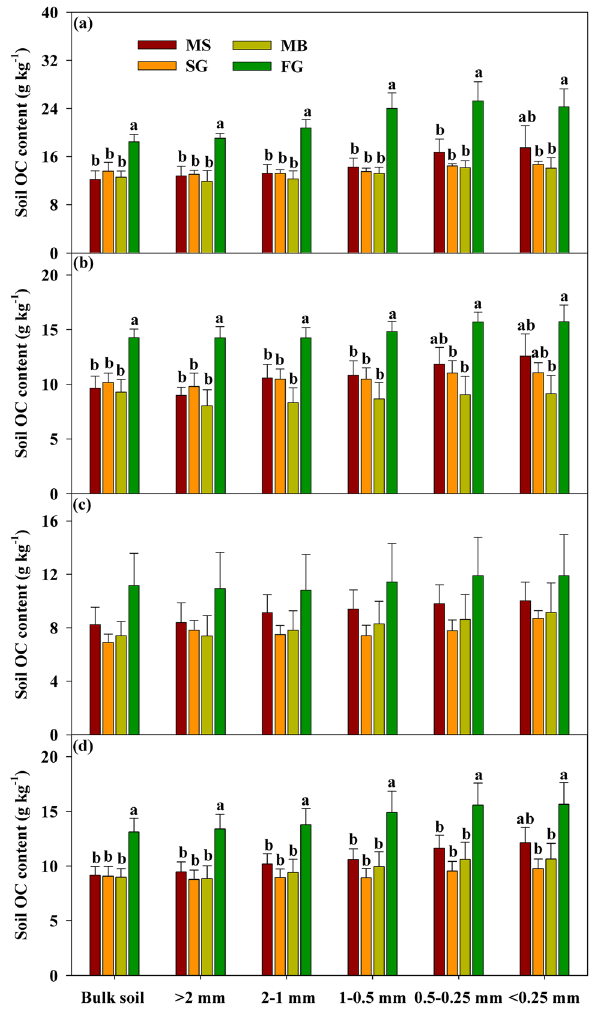
Figure 1. OC contents of bulk soil and aggregate fractions under four land use types at ( a ) 0–10 cm, ( b )10– 20 cm, ( c ) 20–30 cm, and ( d ) 0–30 cm, respectively. Values presented as means with standard error. Different letters indicate significant difference at p < 0.05 among four cropland use types. MS: maize-soybean; SG: sugarcane; MB: mulberry; FG: forage